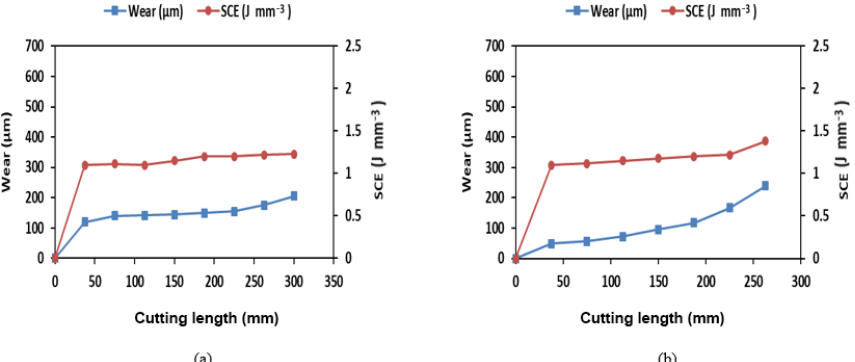
Figure 7. Variation in the SCE due to increase in the wear at different cutting lengths for (low wear region conditions); (a) Condition 6 ( V = 50mmin − 1 , f = 0 . 12mm per rev), (b) Condition 7 ( V = 45mmin − 1 , f = 0 . 24mm per rev).